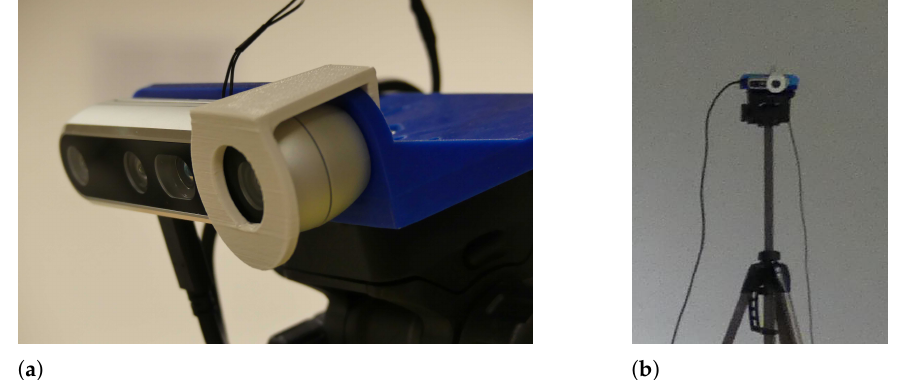
Figure 5. ( a ) The white monocle mounted on the camera. ( b ) The white ring is easily distinguishable, even in low resolution